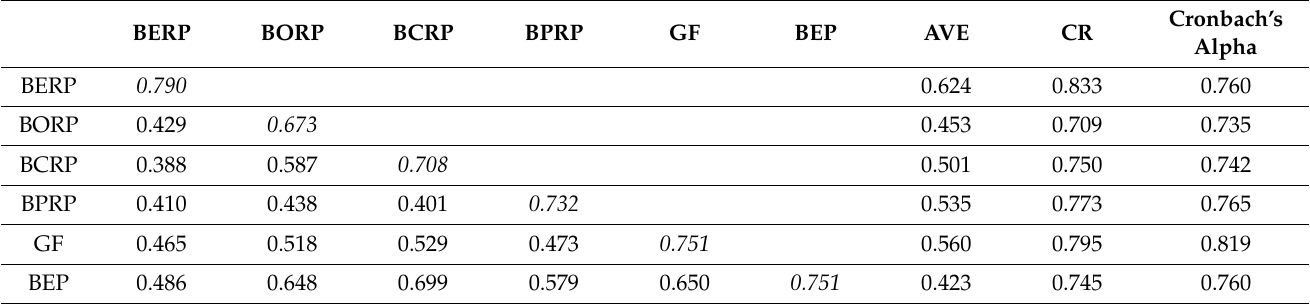
Table 5. Discriminant validity (Fornel–Larker method).